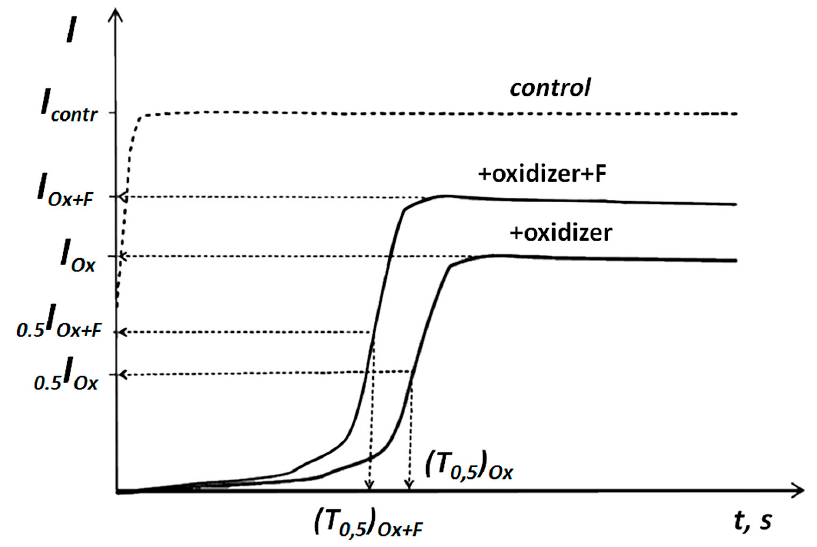
Figure 7. Bioluminescence kinetics of enzymatic assay in a solution of model oxidizers ( Ox ) and fullerene derivatives ( F ) [33].